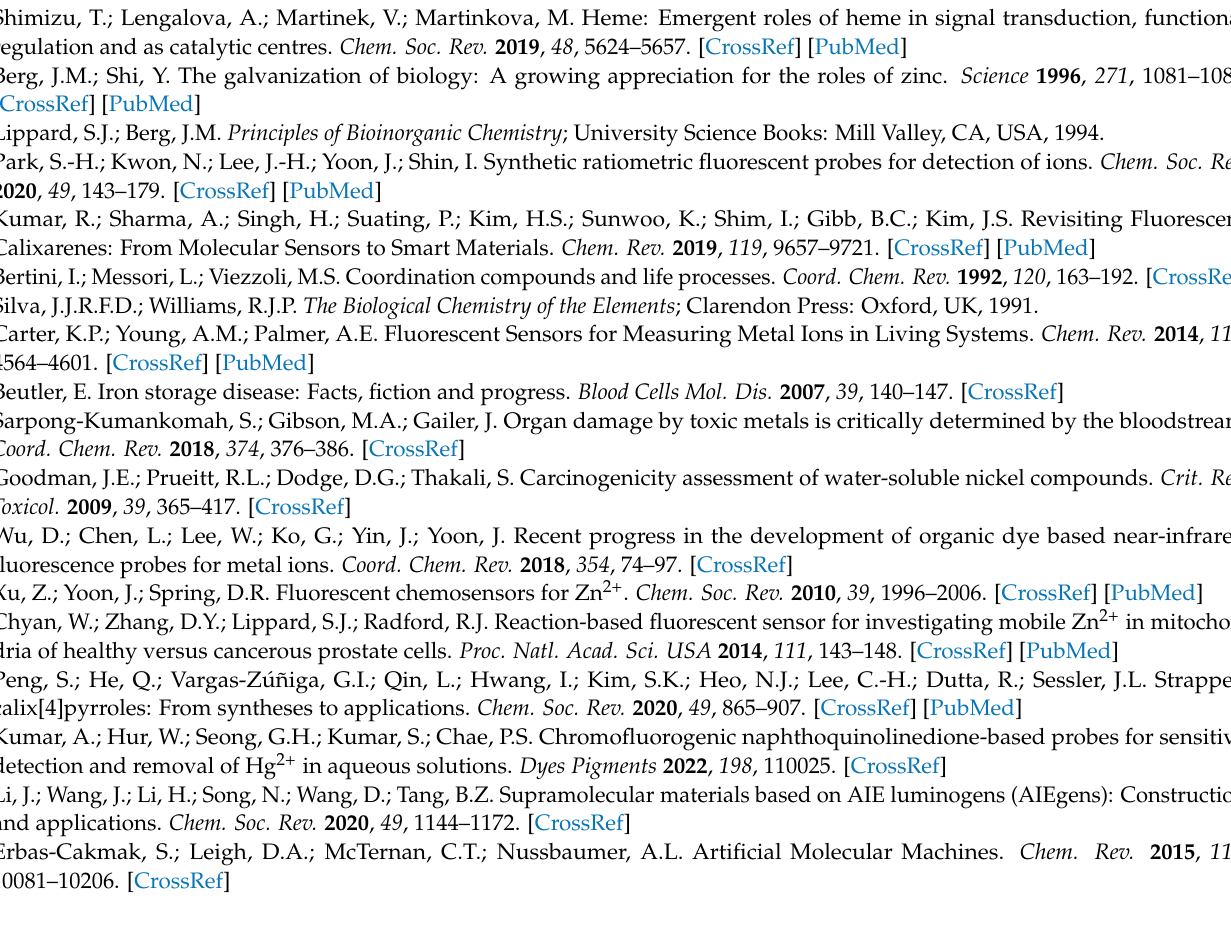
Figure S7: Co-localization images of probe 1 in HeLa cells, Table S1: LOD comparison of probe 1 with other probes previous reported for Cu2+